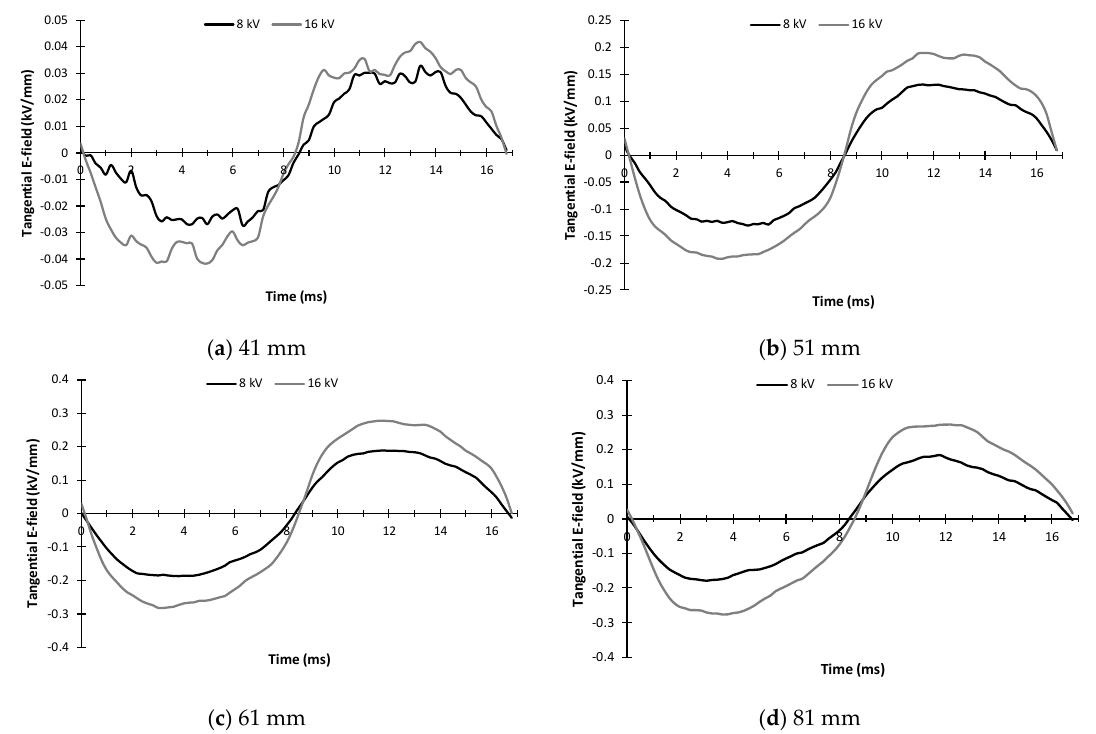
Figure 14. Comparison of the tangential E-field snapshot for applied voltages of 8 kV rms and 16 kV rms obtained at different measuring points along the stress grading system for ( a ) 41 mm, ( b ) 51 mm, ( c ) 61 mm, and ( d ) 81mm.